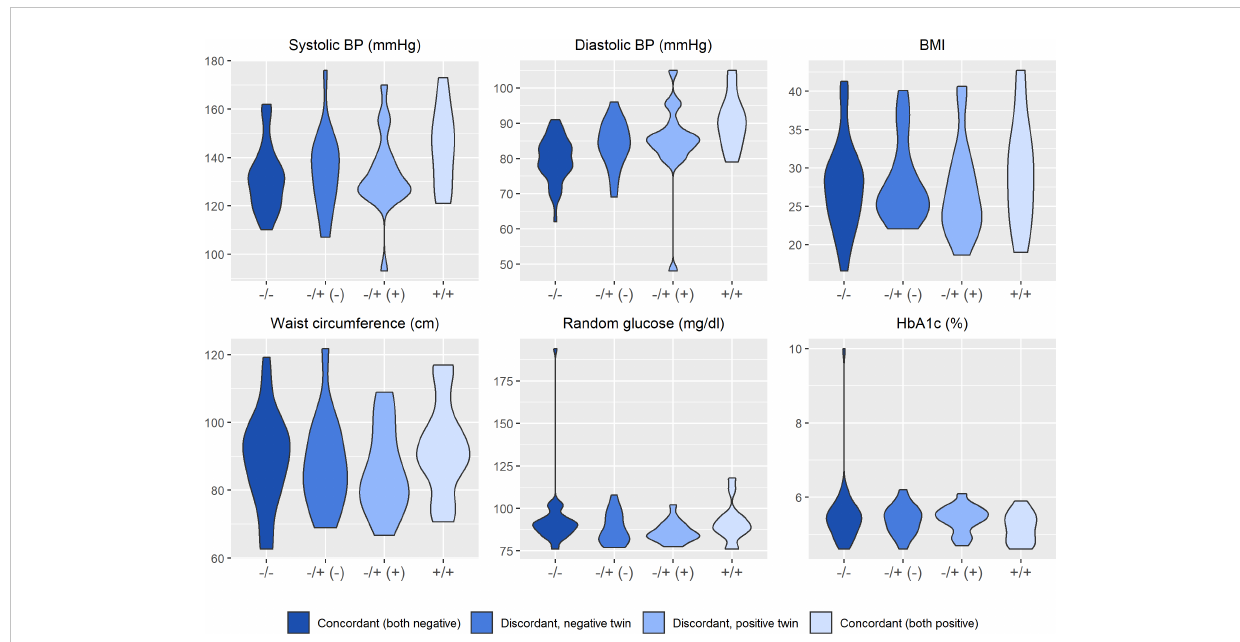
FIGURE 2 Distribution of clinical and metabolic markers arrayed by twin concordance for lifetime history of Major Depression (MD). Distribution of clinical and metabolic indicators by twin concordance for MD as assessed by the Diagnostic Interview Schedule. Units of the Y-axis for each indicator are shown in the subheading above each plot. Each plot is limited to the 42 twin pairs that were con fi rmed to be monozygotic using genetic testing. Sample size for each group shown in the legend: N Corcordant (both do not have MD) = 16 twin pairs (32 individuals), N Discordant for MD (-) = 19 twin pairs (19 individuals), N Discordant for MD (+) = 19 twin pairs (19 individuals), and N Corcordant (both have MD) = 7 twin pairs (14 individuals).